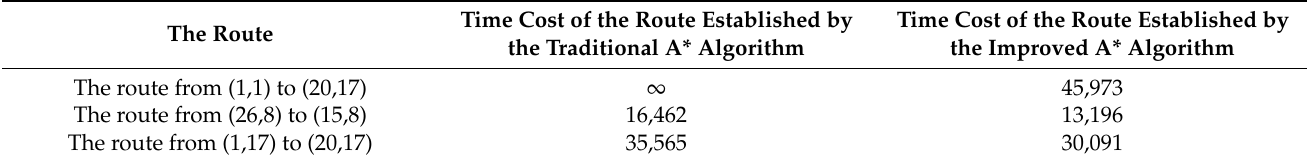
Table 1. Time cost in seconds of the routes established by two algorithms in the grid